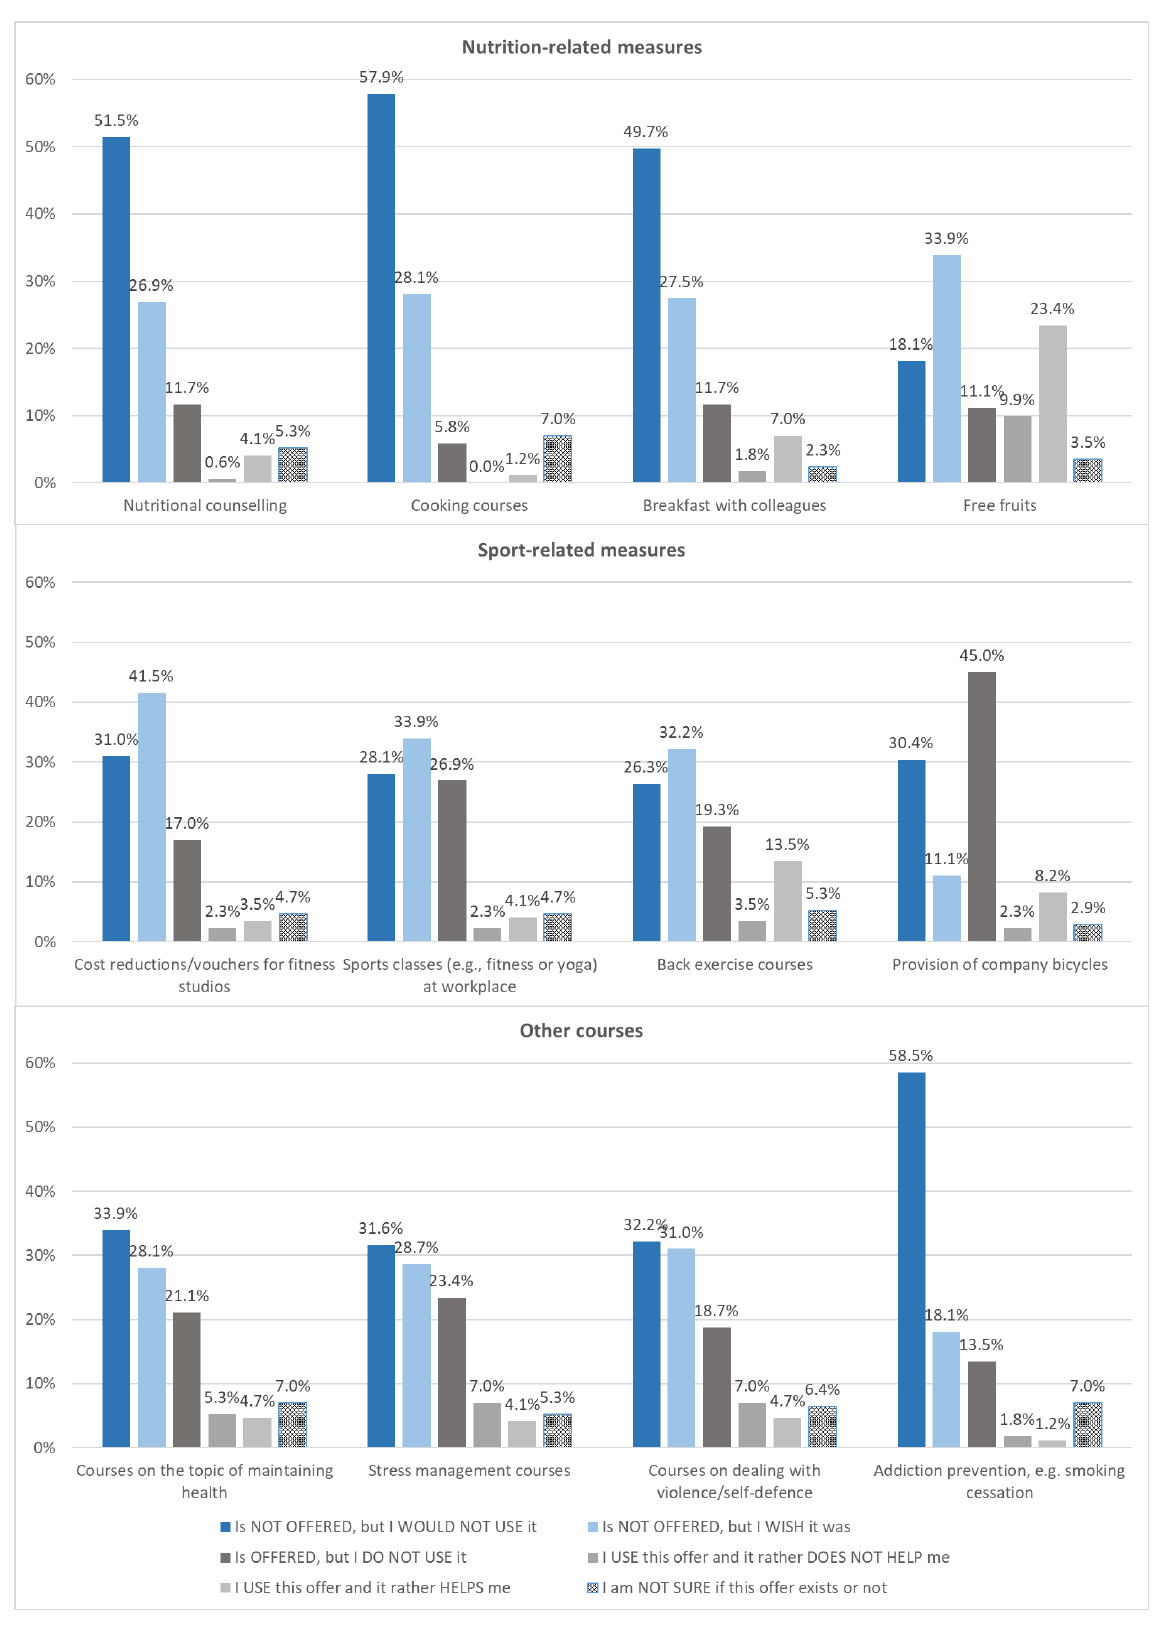
Figure 1. Evaluation of offer, desire, use, and benefit of twelve health promotion measures.